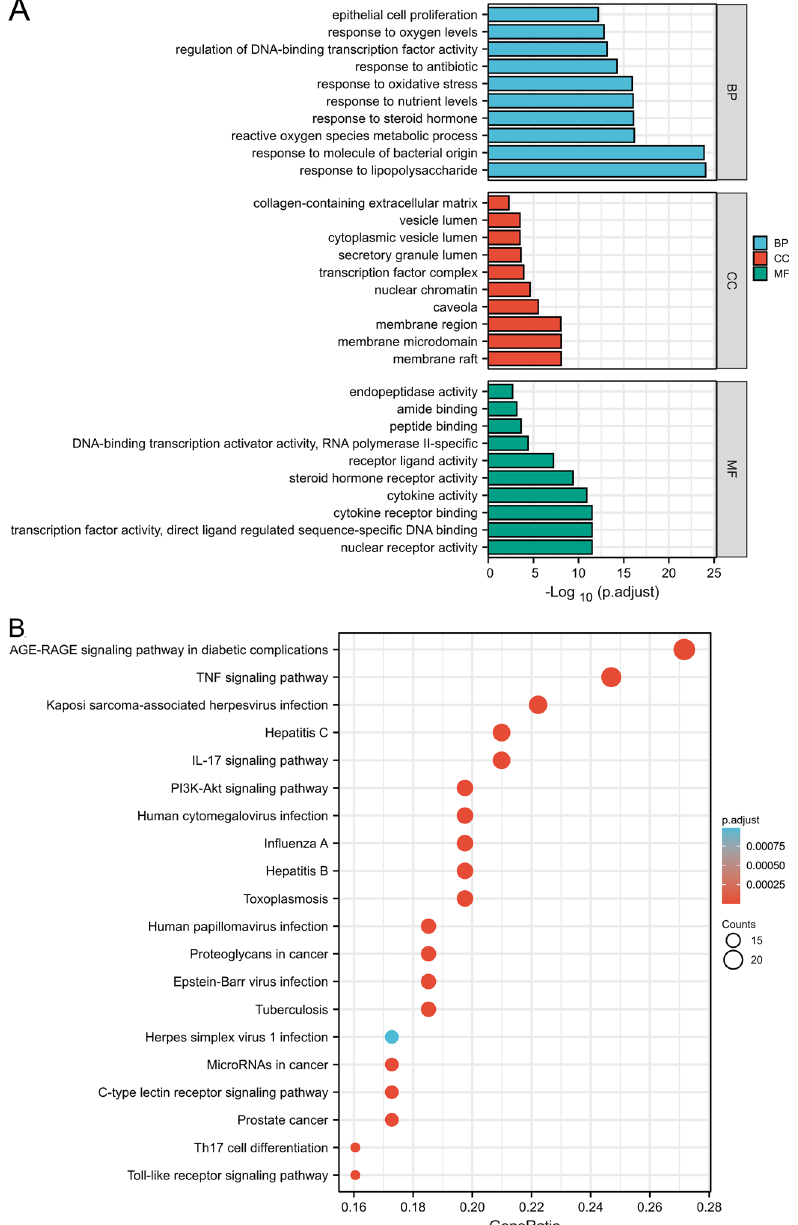
Figure 3. GO and KEGG analysis of potential targets. ( A ) Different colors represent different categories. The height of the column represents the P.adjust value: the higher the value, the higher the reliability of the GO categories (P.adjust < 0.01). ( B ) Dot size indicates the number of target genes in the pathway, and dot color reflects the different P.adjsted value